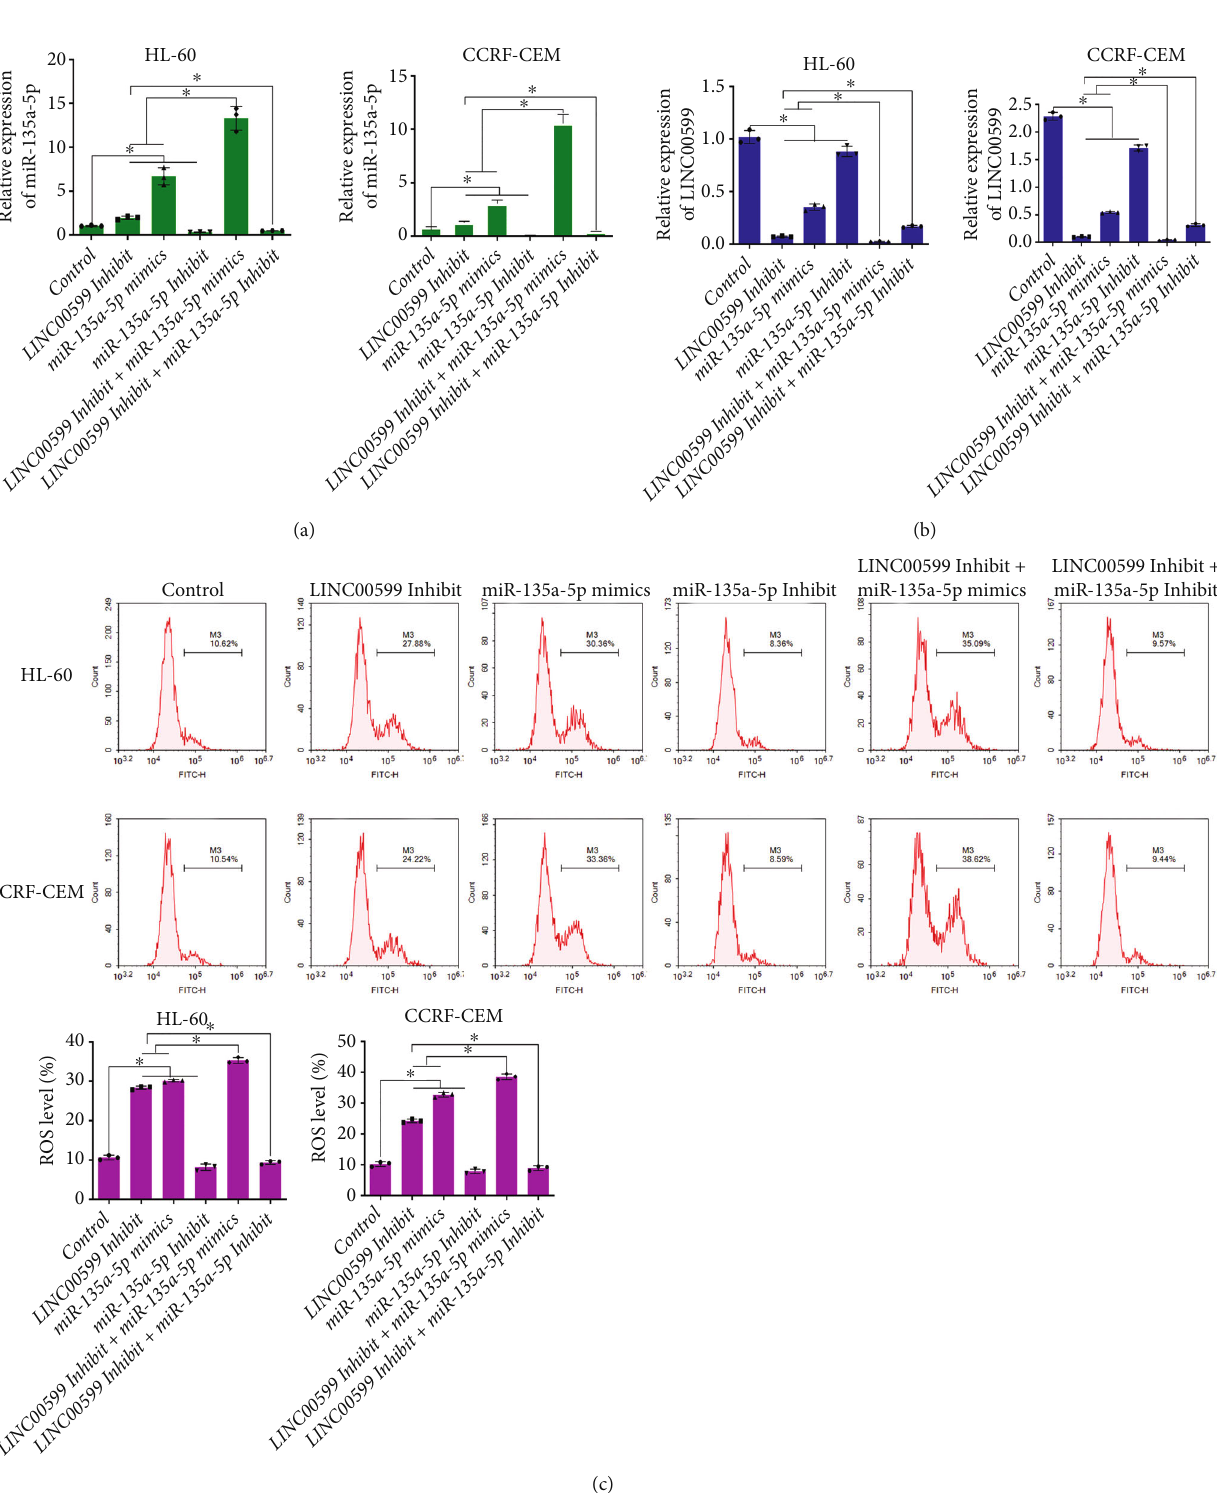
Figure 5: E ff ect of LINC00599 binding to miR-135a-5p on cellular reactive oxygen species (ROS). (a) qPCR analysis detecting the expression of (a) miR-135a-5p and (b) LINC00599 in cells. (c) Flow cytometric analysis detecting the level of ROS in each group of